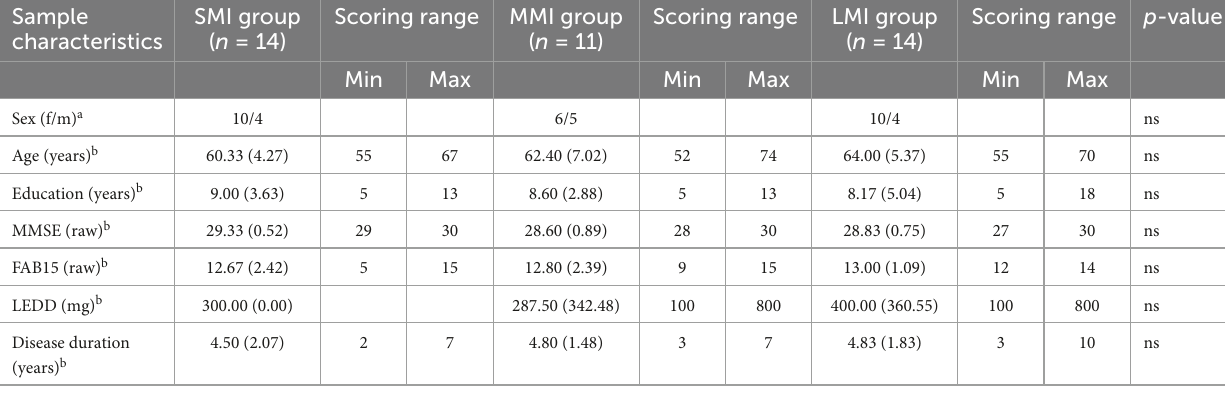
TABLE 2 Descriptive statistics on UPDRS-based groups. Sample